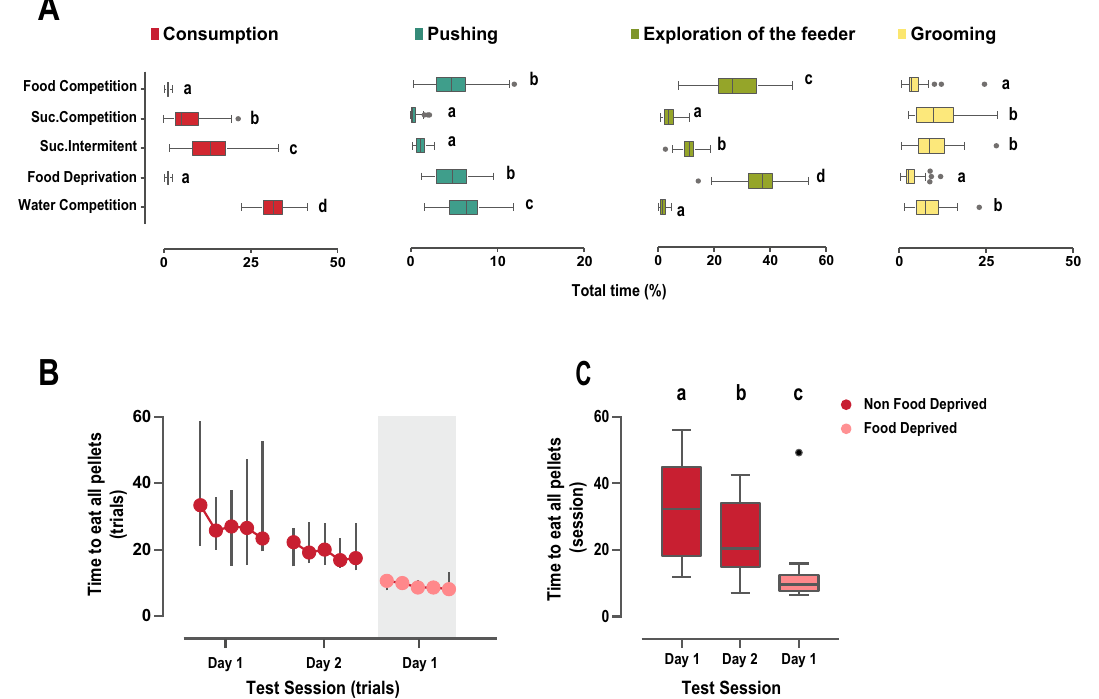
Figure 3. Descriptives of the behavioral analysis for all social tasks involving competition for resources. ( A ) Comparison of the behaviors of interest displayed by each animal across all behavioral tests. Data is presented as percentage of time performing a specific behavior related to the total duration of the task, enabling comparison between tests differing on duration. For those tasks with a trial structure, consumption corresponds to the first 80 s of reward availability for each trial, while pushing, exploration of the feeder and grooming durations correspond to the displays performed during the 40 s before and 80 s after reward availability. When more than one day of testing was performed, data represents average of the two days. Each competition test provided very different behavioral profiles, where the duration of consumption and exploration of the feeder or pushing behaviors to access the resources differed clearly over the tests. Note that pellets in the modified Food Competition test were consumed during the first seconds, but still high levels of pushing and exploration of the feeder where observed. However, the time spent consuming sucrose and the levels of pushing for accessing the bottle were low. Boxplots depict the median and quartile 1 and 3, whiskers indicate minimum and maximum values and extreme values are signaled as a dot. Consumption in red, Pushing in dark green, Exploration of the Feeder in light green, Grooming in yellow. Letters denote statistically significant differences between behavioral tests after one-way ANOVA with Tukey posthoc comparisons. Time spent grooming was not normally distributed, thus non-parametric analysis was performed. ( B ) Latency to eat all pellets for each trial is shown in the Food Competition tests, with or without deprivation where median and 95% CI for each trial are represented. Animals only took around 20 s to eat all pellets available, decreasing this latency when food deprived. Shaded background indicates session performed under food-deprivation. ( C ) Boxplots representing the average time to eat all pellets over testing days. Wilcoxon rank test revealed that latency to eat the pellets decreased on the second day of testing of the modified Food Competition test, and did further under deprivation state. ** p < 0.01, *** p <